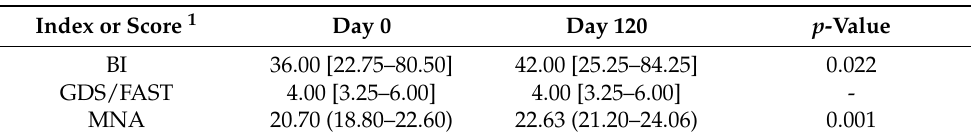
Table 2. Assessment of the functional, cognitive, and nutritional status of the participants at the start and at the end of the trial. Values are expressed as mean (95% CI) or median